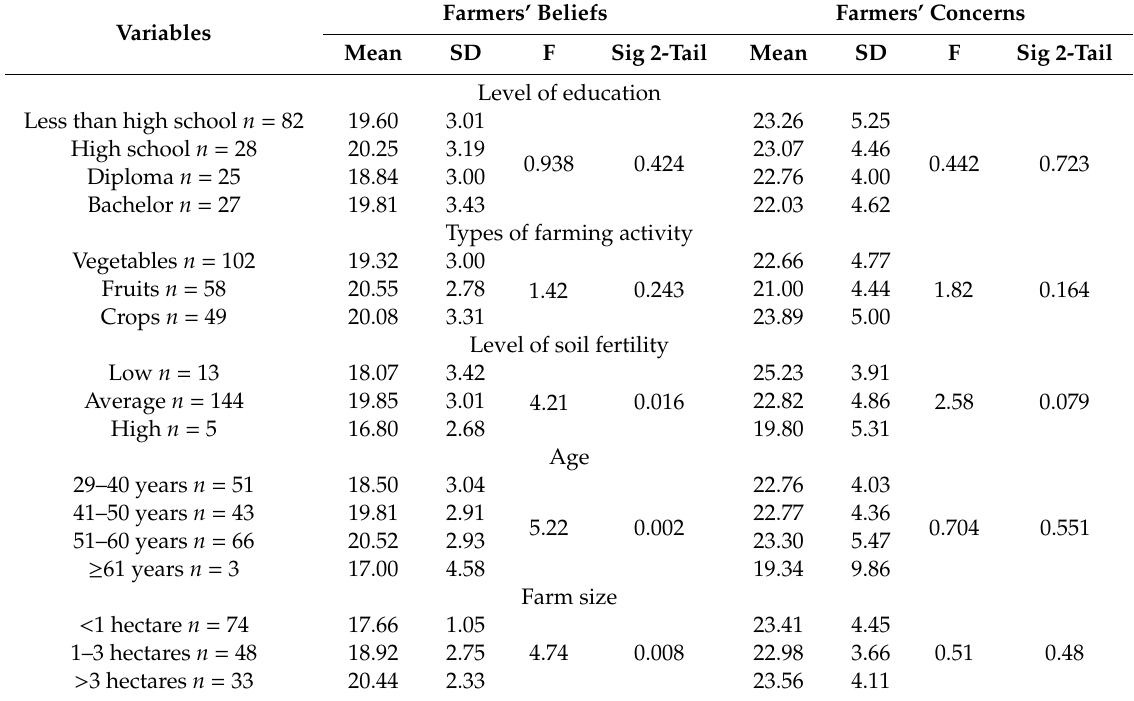
Table 7. ANOVA di ff erences in farmers’ beliefs and concerns about climate change with regard to socio-economic characteristics.